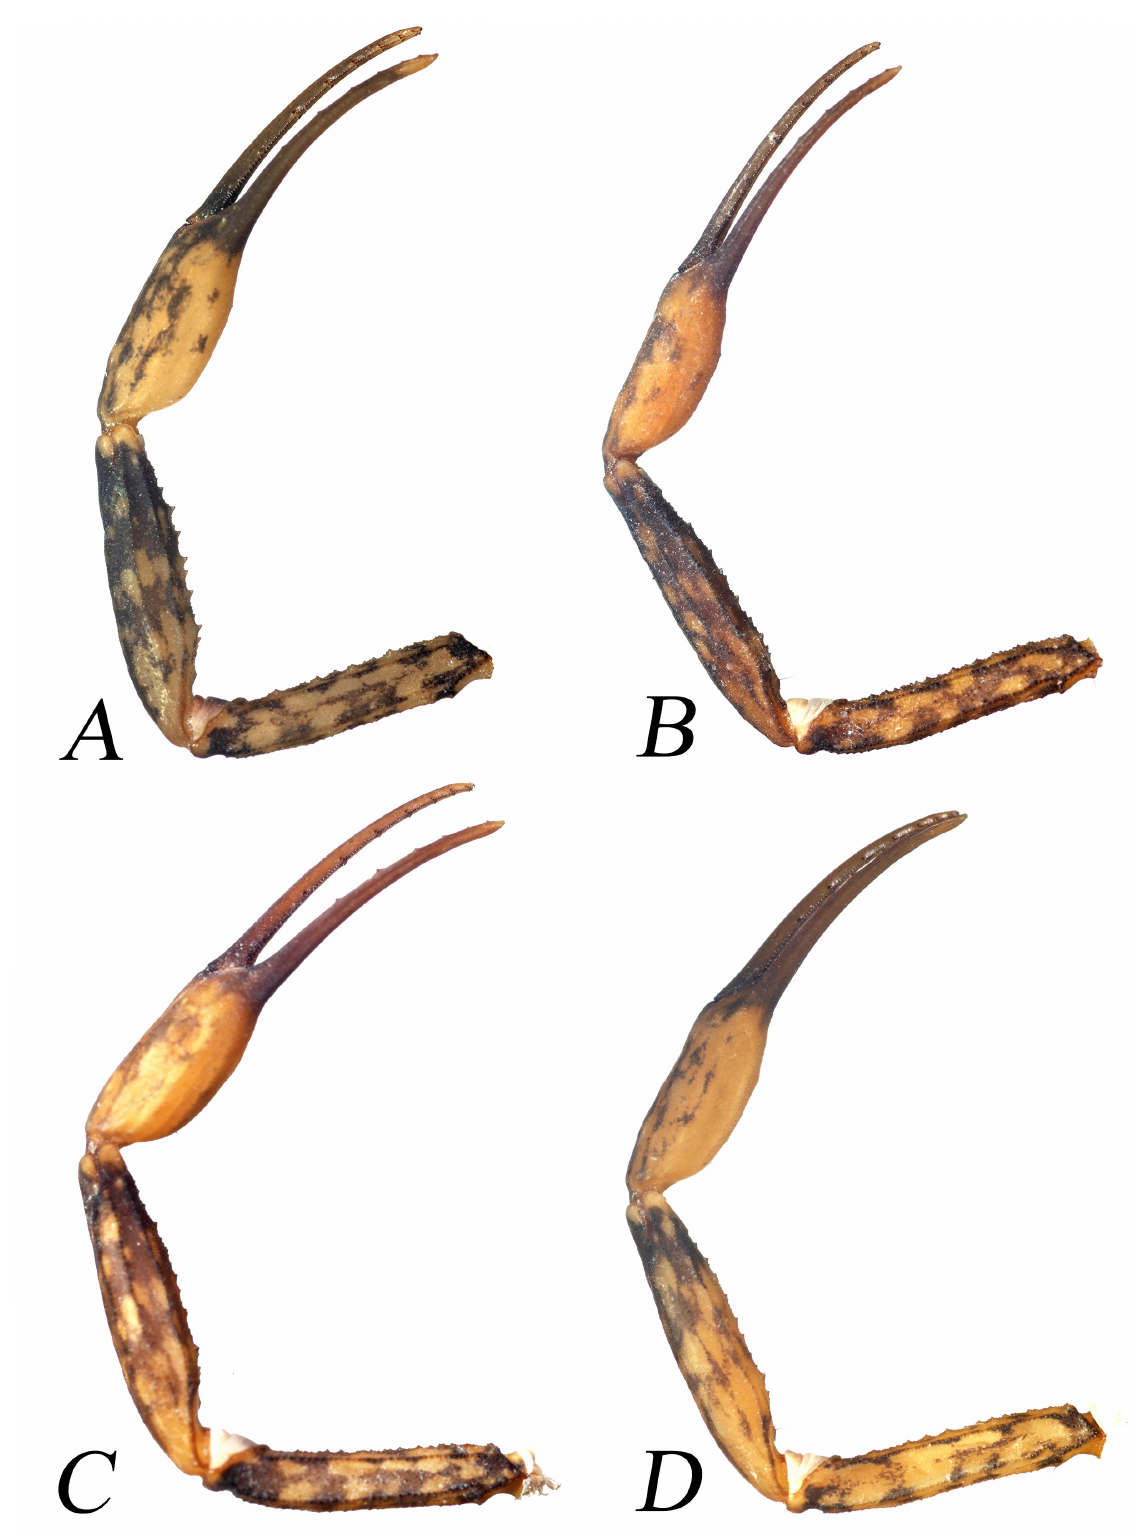
Fig. 24. Comparison of left pedipalps. A . Isometrus thurstoni Pocock, 1983, topotype, adult ♂ (INHER 139). B . I. tamhini Sulakhe et al ., 2020, holotype, adult ♂ (BNHS SC 155). C . I. amboli Sulakhe et al., 2020, holotype, adult ♂ (BNHS SC 157). D . I. kovariki Sulakhe et al ., 2020, holotype, adult ♂ (BNHS SC